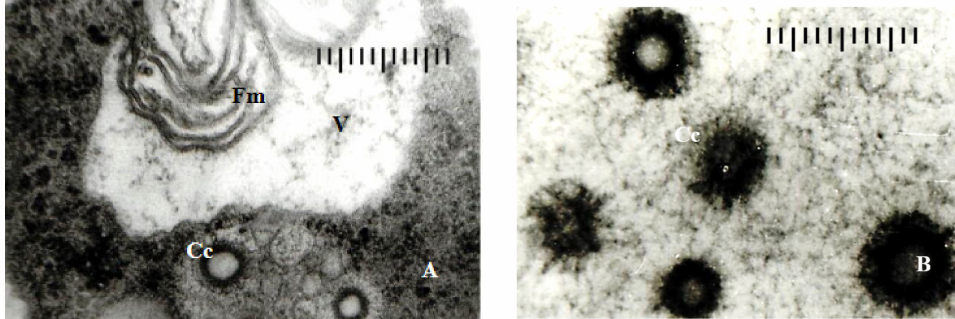
Figure 8. Electron-microscopic appearance of concentric bodies in the median cells of some vegetative (transversal ultrasections). ( A ): Fm—myelin formations (concentric membranes); V—vacuole; Cc—concentric bodies; (bar-400 nm). ( B ): Cc—concentric bodies; (bar-200